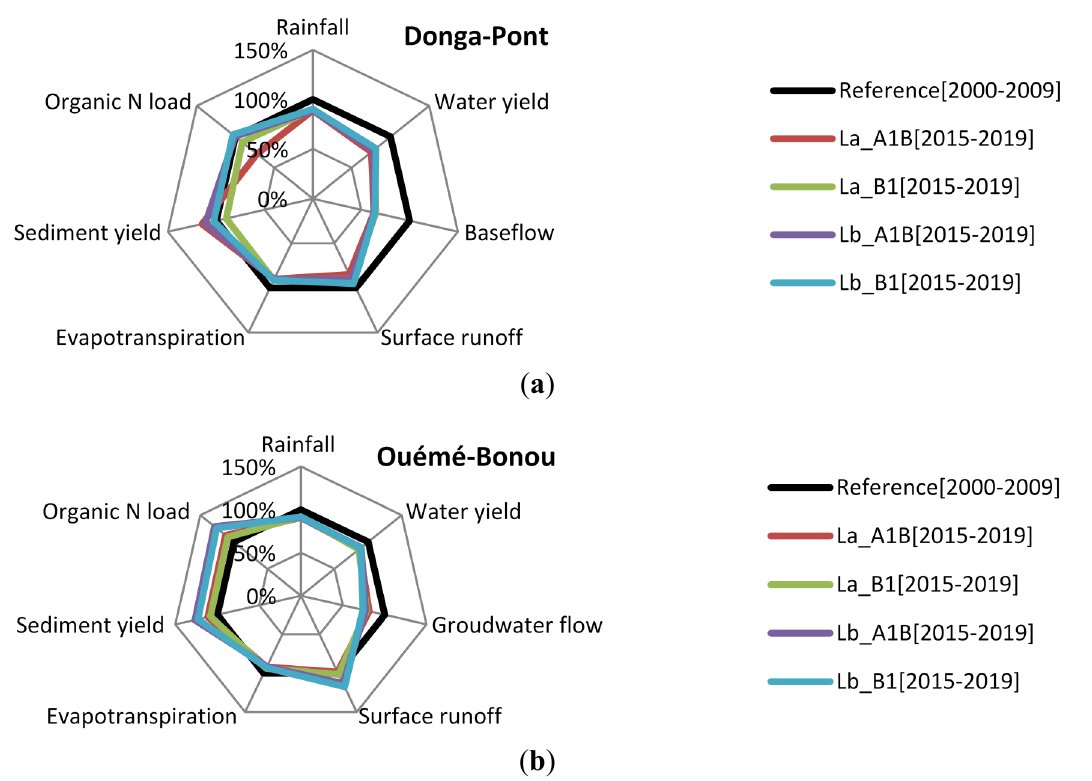
Figure 13. Simulated trends under land use and climate scenarios (2015 to